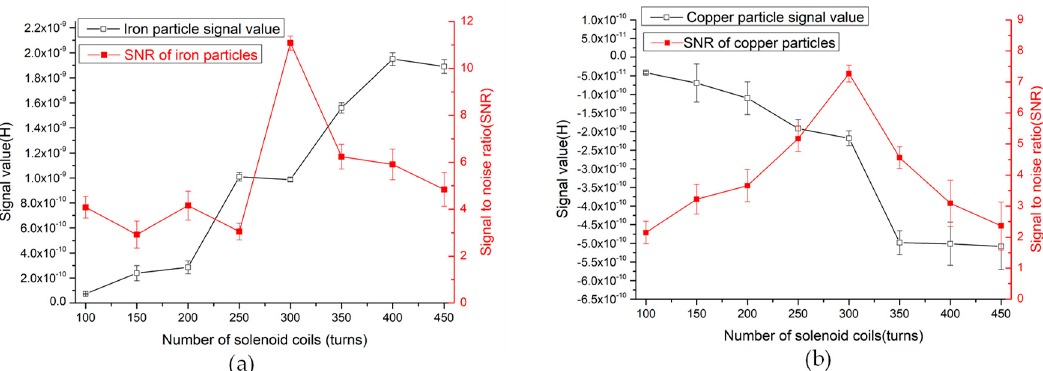
Figure 8. ( a ) Detection results of 40 μ m iron particles by sensors with different turns; ( b ) detection results of 90 μ m copper particles by sensors with different turns.